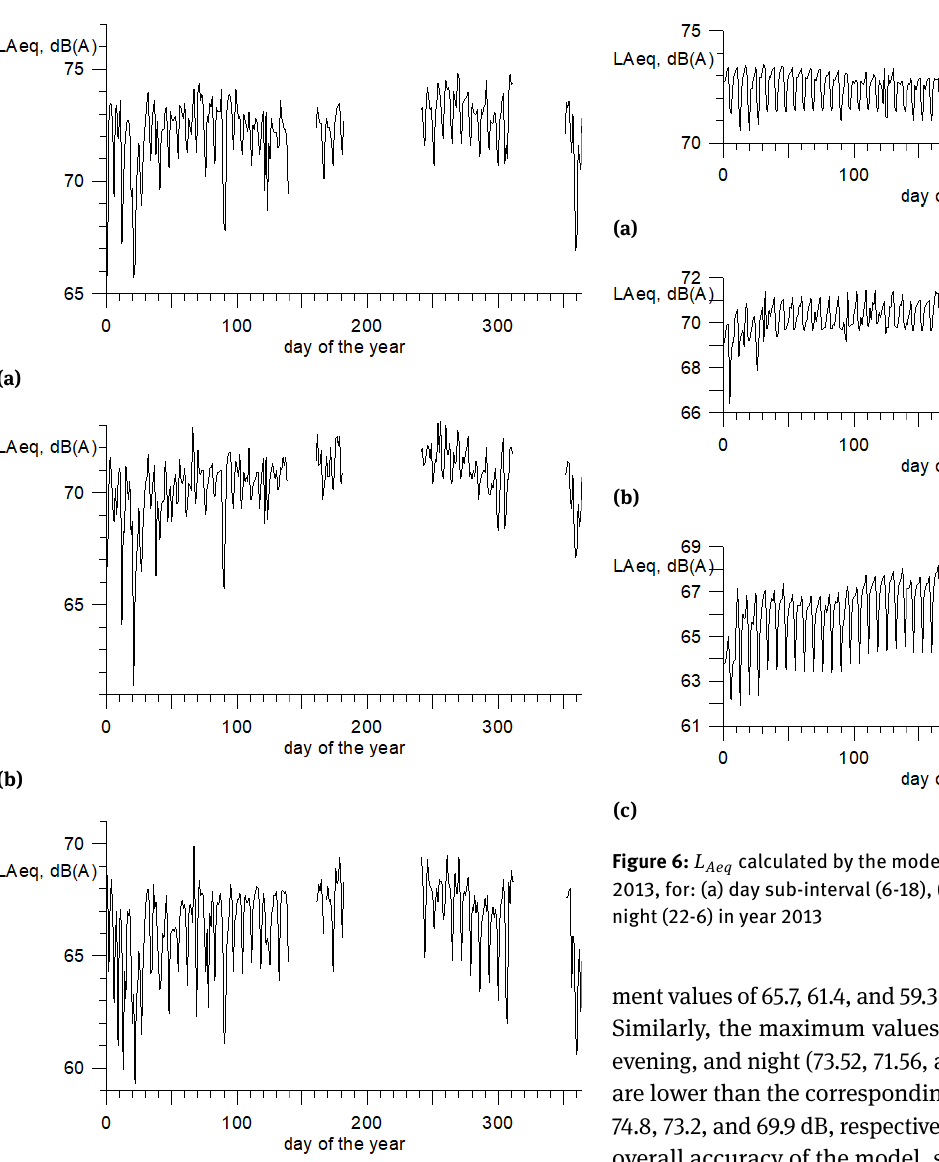
Figure 5: L Aeq calculated from measurements made at the location no. 3, in year 2013, for: (a) day sub-interval (6-18), (b) evening (18- 22), and (c) night (22-6) in year 2013 interval were recorded at national holidays and in January and December.